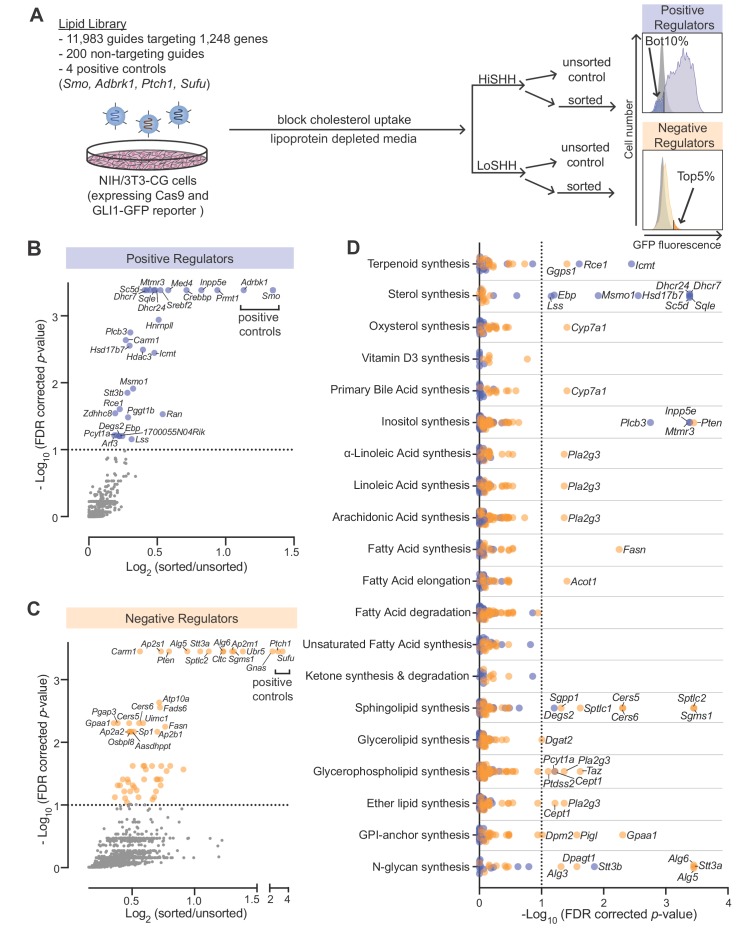
CRISPR screens identify lipid-related genes that influence hedgehog signaling.(A) Flowchart summarizing the screening strategy. Screens for positive and negative regulators used a high, saturating concentration of SHH (HiSHH, 25 nM) or a low concentration of SHH (LoSHH, 3.2 nM), respectively. (B and C) Volcano plots of the HiSHH-Bot10% (B) screen for positive regulators and the LoSHH-Top5% (C) screen for negative regulators. Enrichment is calculated as the mean of all sgRNAs for a given gene in the sorted over unsorted population, with the y-axis showing significance based on the false discovery rate (FDR)-corrected p-value. (D) Screen results analyzed by grouping genes based on the core lipid biosynthetic pathways in KEGG. In all panels, genes identified as positive and negative regulators are labeled in blue and orange respectively. See Supplementary file 4 for the full analysis.